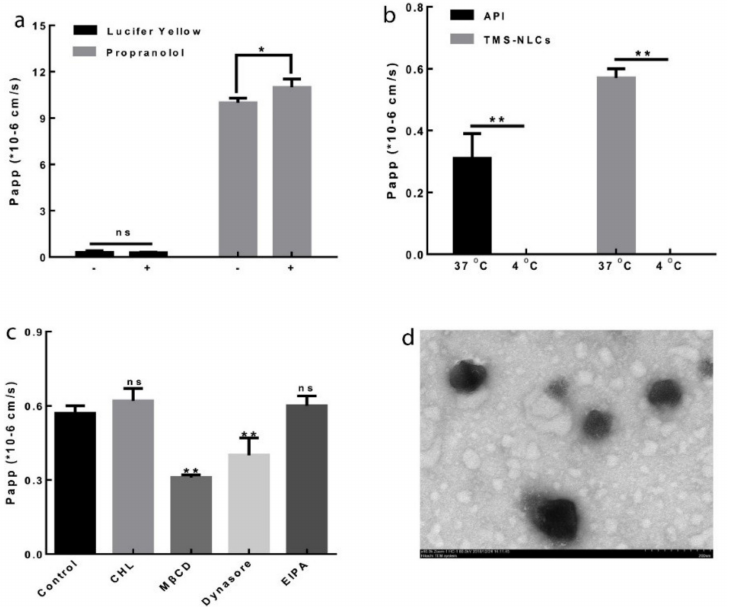
Figure 3. Pathway of tilmicosin-loaded NLCs transport into Caco-2 cell monolayers. ( a ) Effect of NLCs on P app of Lucifer Yellow and propranolol (+ and -: treated with and without tilmicosin- loaded NLCs, respectively). ( b ) The P app of tilmicosin-loaded NLCs (TMS-NLCs) and tilmicosin (API) at 4 ◦ C and 37 ◦ C. ( c ) The effect of various endocytosis inhibitors on the P app of TMS-NLCs. CHL: chlorpromazine, M β CD: methyl- β -cyclodextrin, EIPA: 5-(N-ethyl-N-isopropyl)-amiloride, ns: no significance. * p < 0.05 and ** p < 0.01 compared with control. ( d ) After 4h of transcellular transport, TMS-NLCs from the A-to-B side transport fluids were collected to observe the nanoparticle morphology by TEM. Scale bar was 200nm. Reprinted from [174], Copyright (2019), with permission from